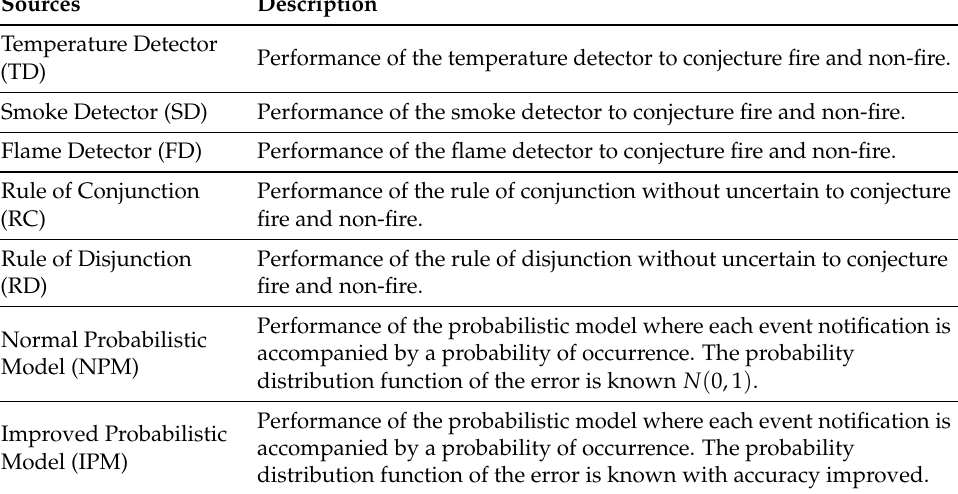
Table 3. Baseline of